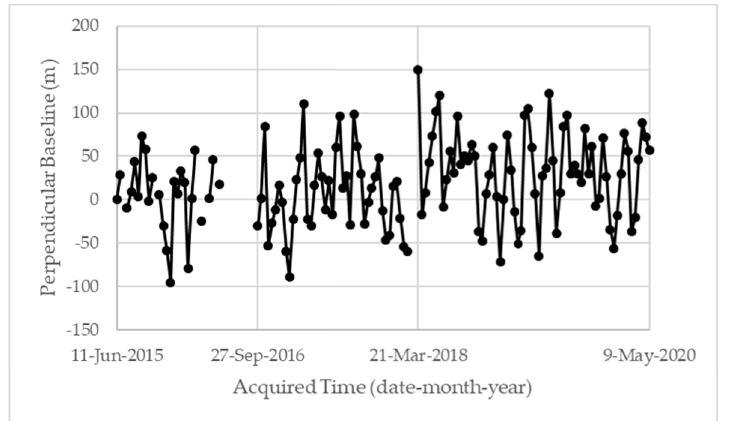
Figure 4. InSAR coherence dataset with a 12-day temporal baseline. Points represent SAR data, while lines are 12-day coherence data with a perpendicular baseline.